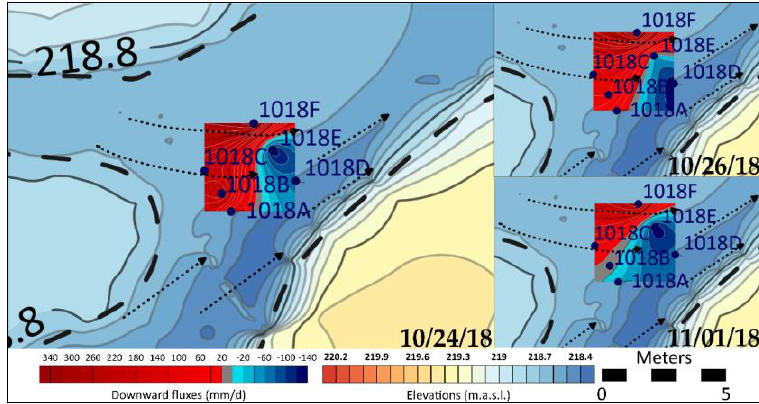
Figure 9. Vertical hyporheic fluxes (mm/day) for September 2018, derived from temperature profiles. Figure 10. Vertical hyporheic fluxes (mm/day) for 23 October to 6 November 2018, derived from Downwelling and upwelling fluxes are represented by red and blue contours, respectively. The light temperature profiles. The light blue contour represents an interpolated transitional zone. blue contour represents an interpolated transitional zone.